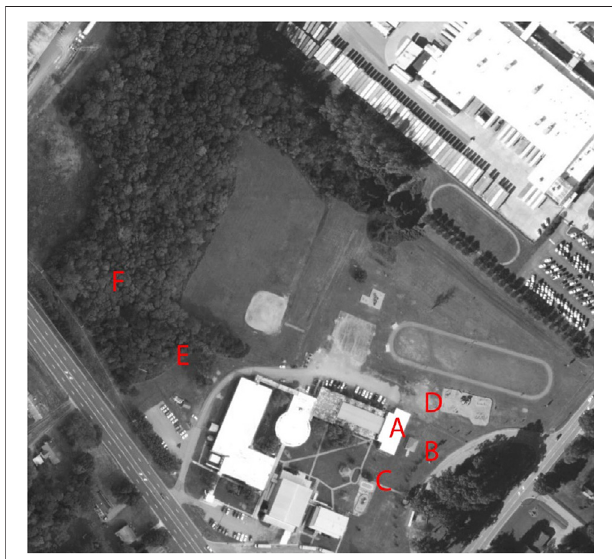
FIGURE 1 | Belington elementary campus. A (cid:1) Indoor Classroom, B (cid:1) Outdoor Classroom, C (cid:1) Pavilion, D (cid:1) Playground and Blacktop Area, E